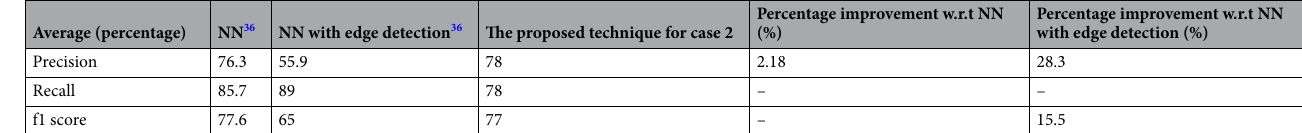
Table 10. Percentage improvement of proposed case 2 w.r.t base cases.